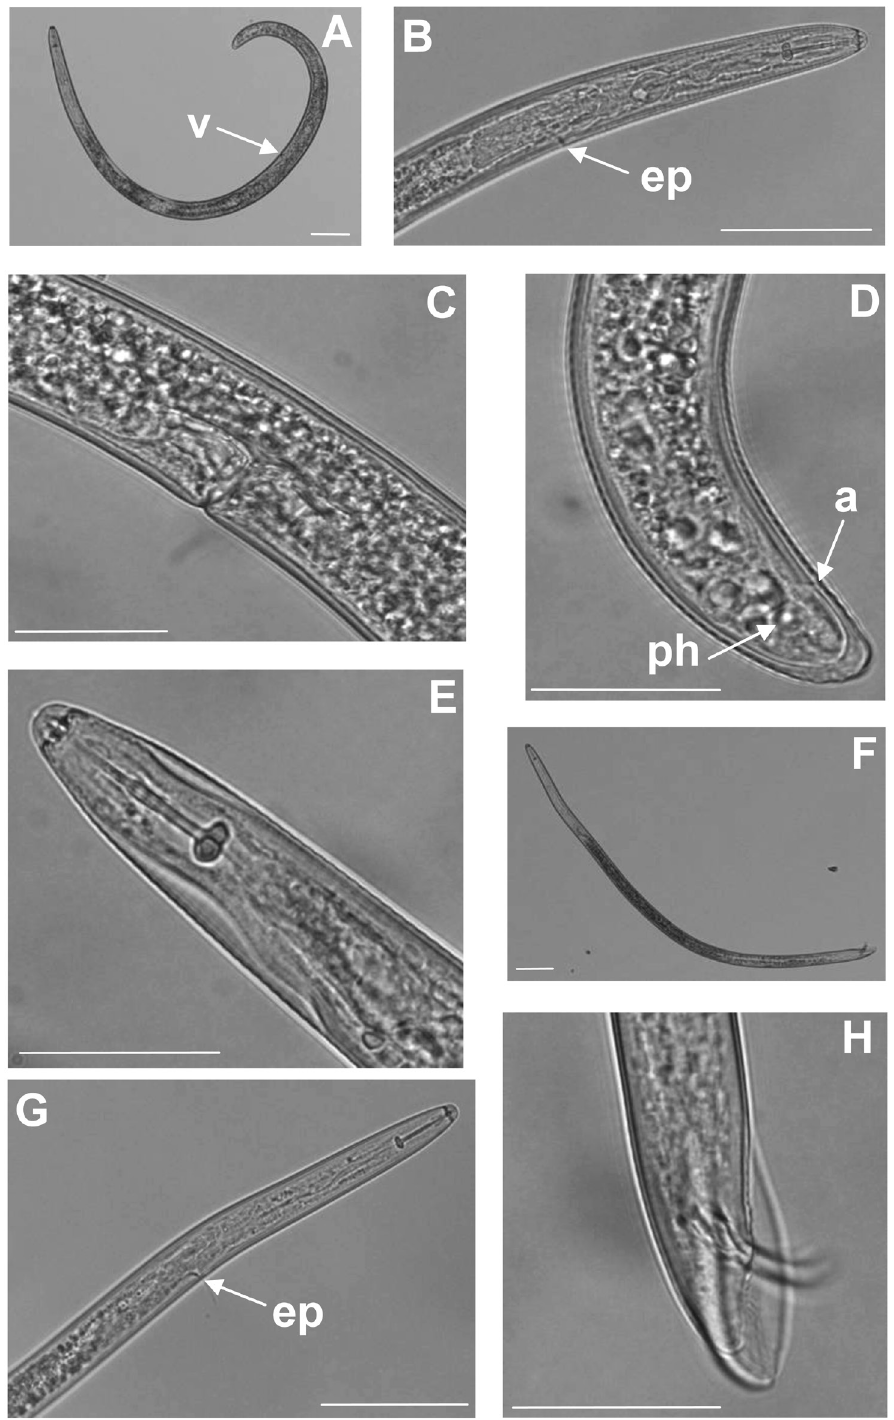
Figure 2. Helicotylenchus varicaudatus . Females (A–E). Habitus (A), anterior region, lateral (B), vulva region (C), tail (D) and head (E). Males (F–H). Habitus (F), anterior region (G) and tail (H). v, vulva; ep, excretory pore; a, anus; ph, phasmid. Scale bars: A, B, F, G=50 µ m; C, D, E, H=25 µ